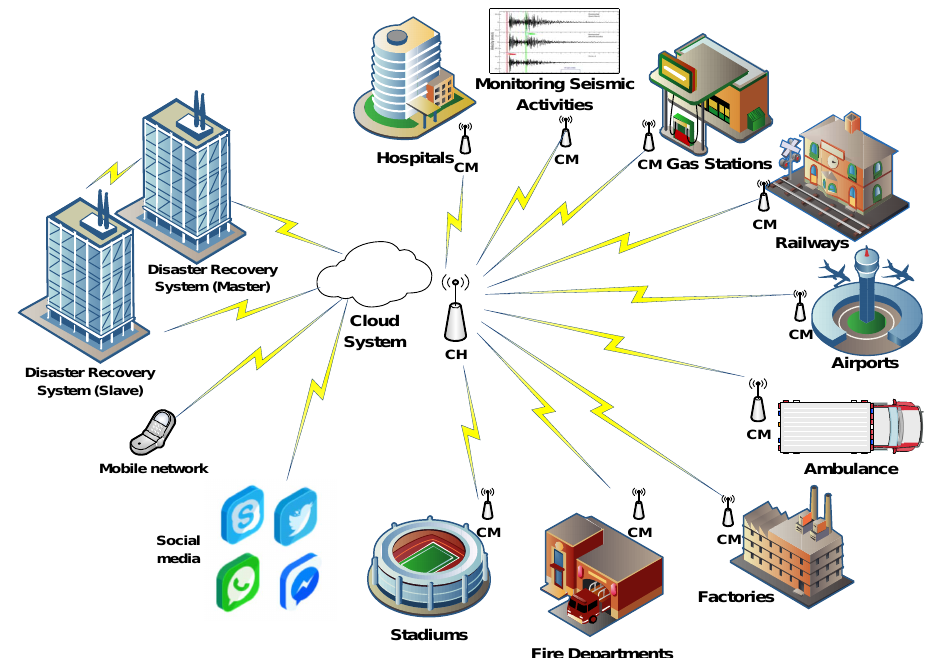
Figure 3. General diagram for a comprehensive EWS.